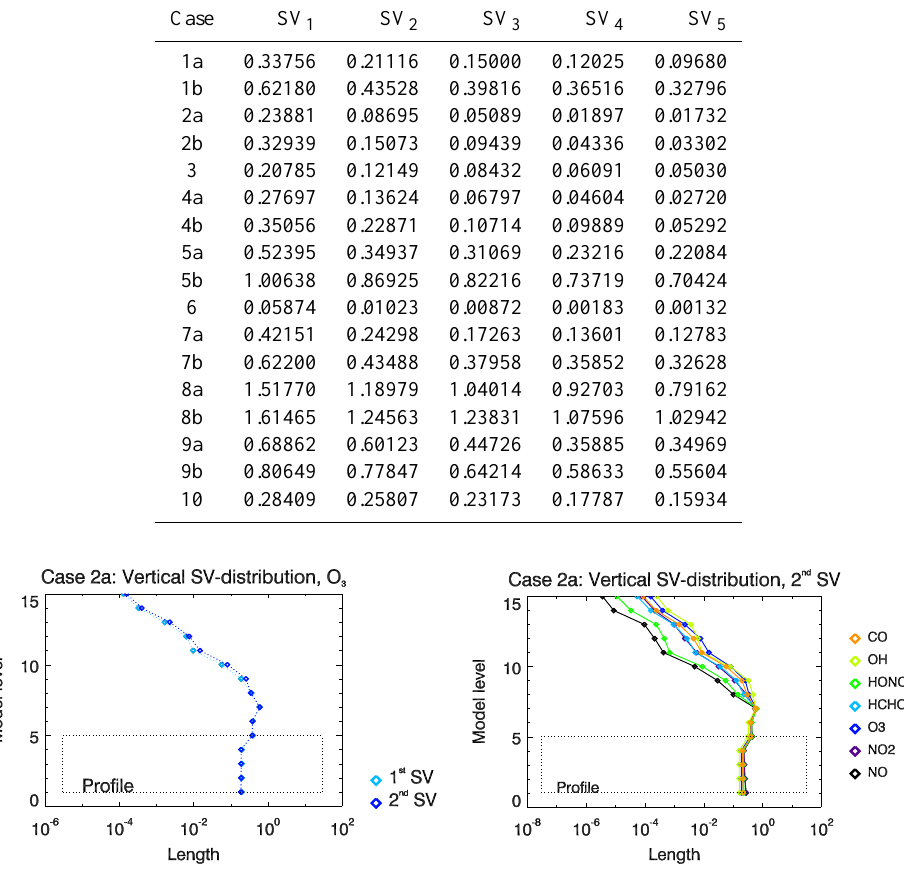
Figure 3. Vertical placement of the first and second singular vectors with respect to initial value uncertainties for case 2a. Illustrated is the length of the first and second vertical singular vectors per model level for ozone (left panel) as well as the length of the second vertical singular vector for CO, OH, HONO, O 3 , NO 2 , and NO (right panel). Colour coding of each compound is denoted to the right of each panel. The black box indicates the height of the final profile VP( t F